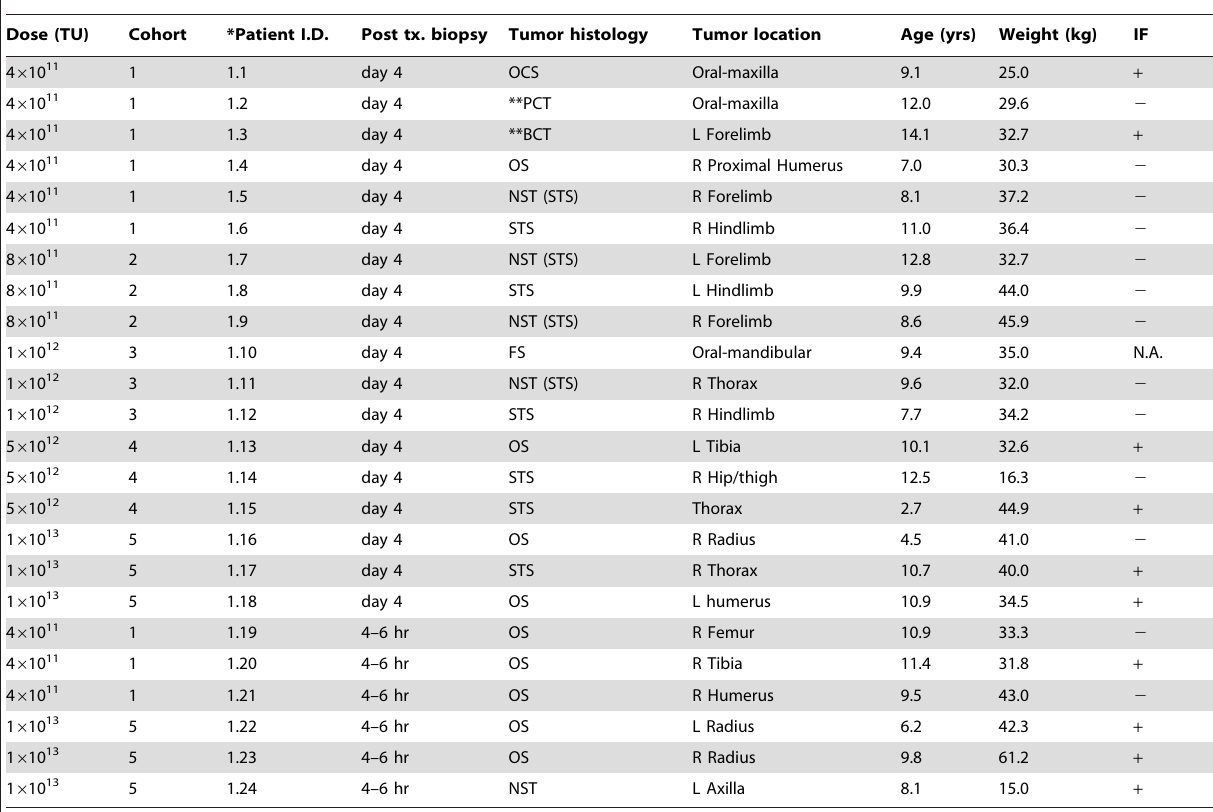
Table 1. RGD-A- TNF Dose Escalation Study: Patient Population and RGD-A- TNF Trafficking Data